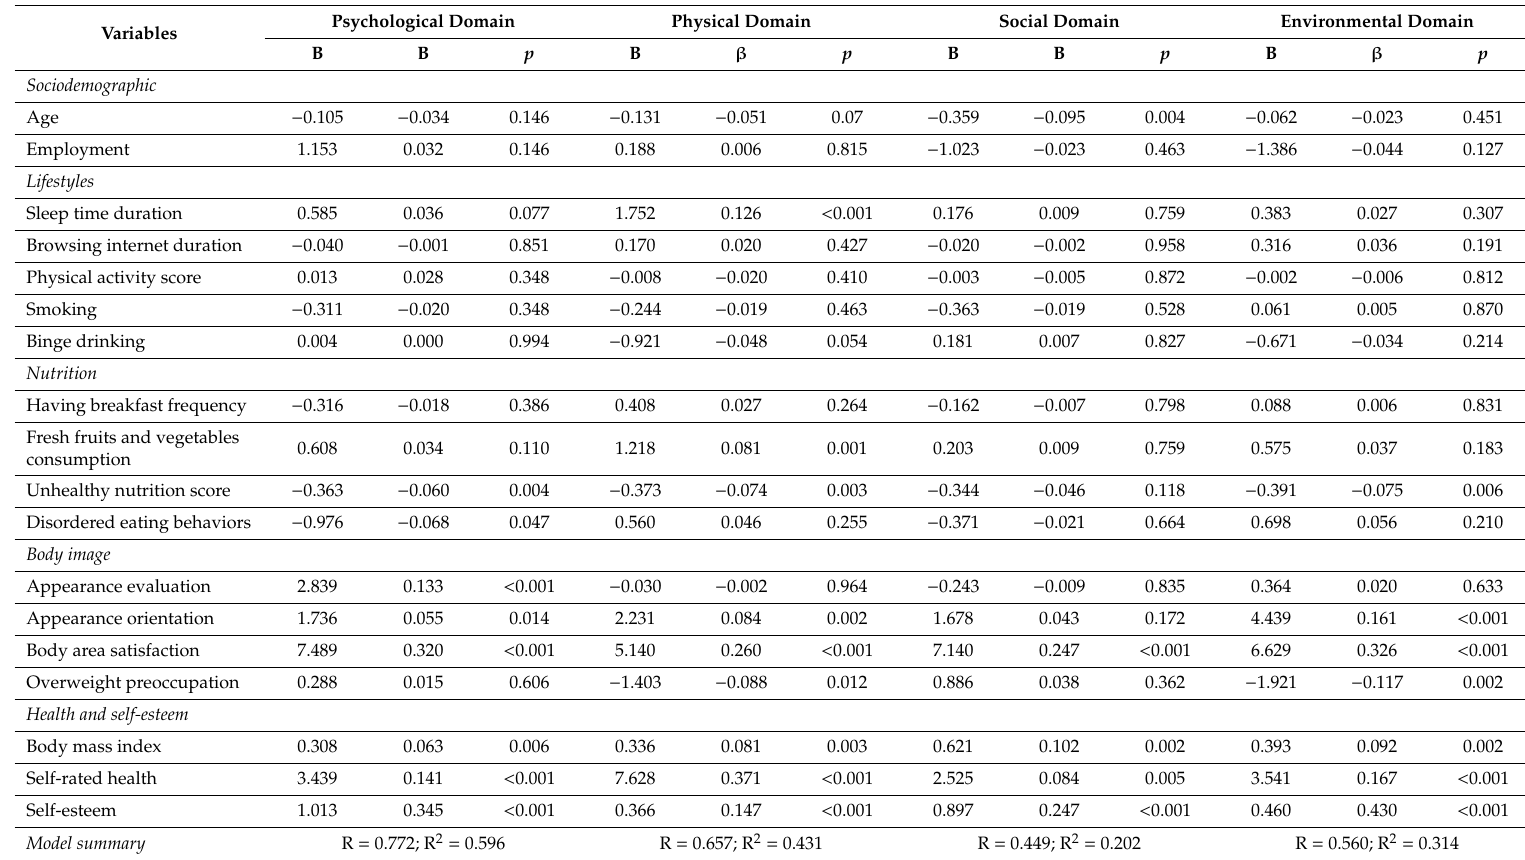
Table 2. Variables associated with di ff erent domains of the quality of life in female students ( n = 1087). Psychological Variables